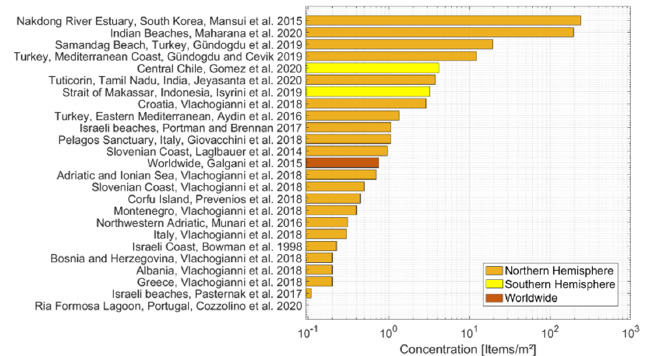
Figure 5. Concentrations of MaP on shorelines differentiates between the northern and southern hemisphere (data based on [115,122,144,149,151–163]).